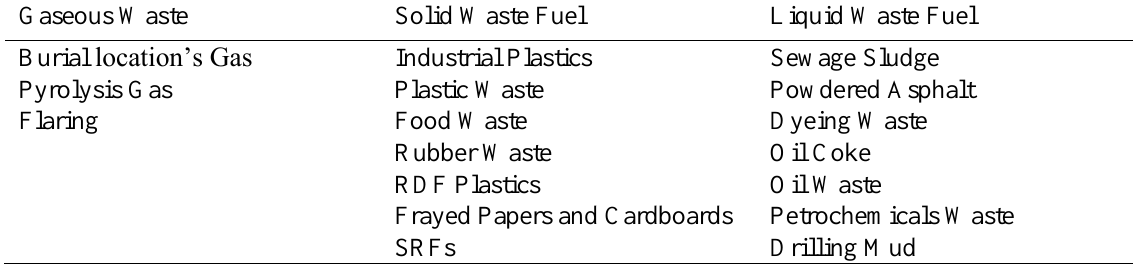
Table 2 . Alternative fuels derived from different wastes according to their phases Gaseous